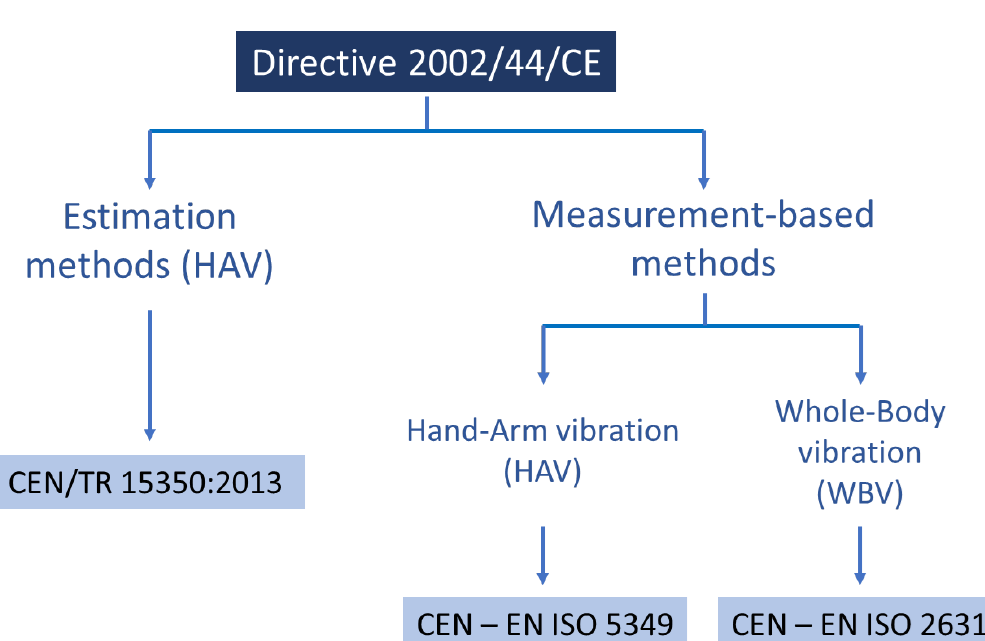
Figure 2. Schematic view of the applicable technical regulations for hand-arm transmitted vibration (HAV) and whole-body vibration (WBV).